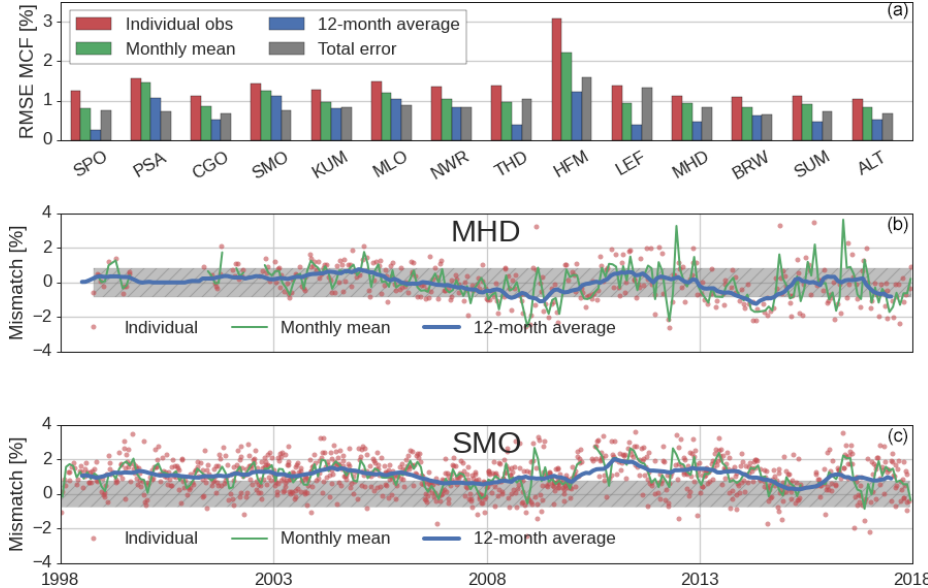
Figure 6. (a) Posterior root-mean-squared errors (RMSEs) per surface site, for the REF inversion. RMSEs are shown for individual observa- tions, for monthly mean, and for 12-month running mean MCF mole fractions. Additionally, the site-dependent average total error that was used in the inversions, combined from a model and measurement error, is shown. RMSEs are averages over the 1998–2018 inversion period and are given relative to the measured MCF mole fraction. Site abbreviations are explained in Table S2. (b, c) Time series of the posterior measurement–model mismatch at MHD (a) and SMO (c) from individual observations, from monthly means, and from 12-month running averages, with the average total error shaded in gray.